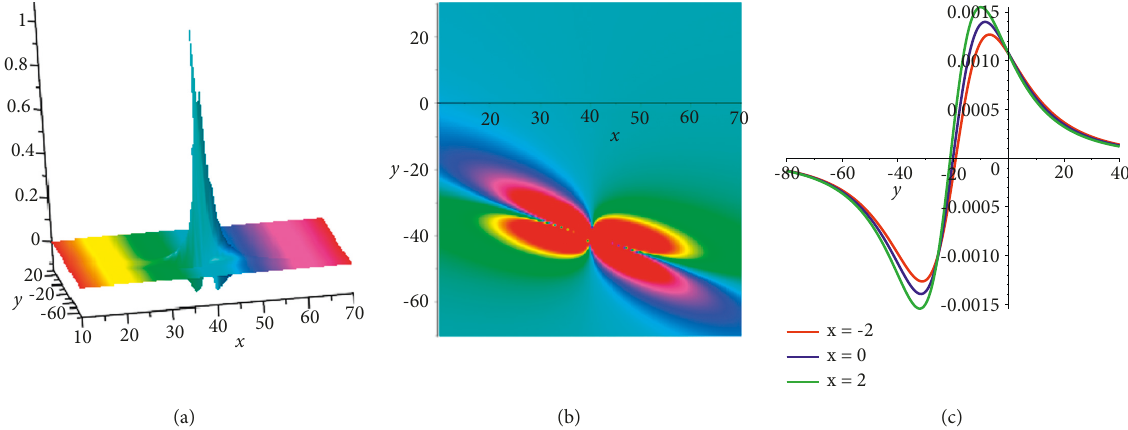
Figure 3: Plot of equation (44) by taking a � 1 , b � − 1 , c